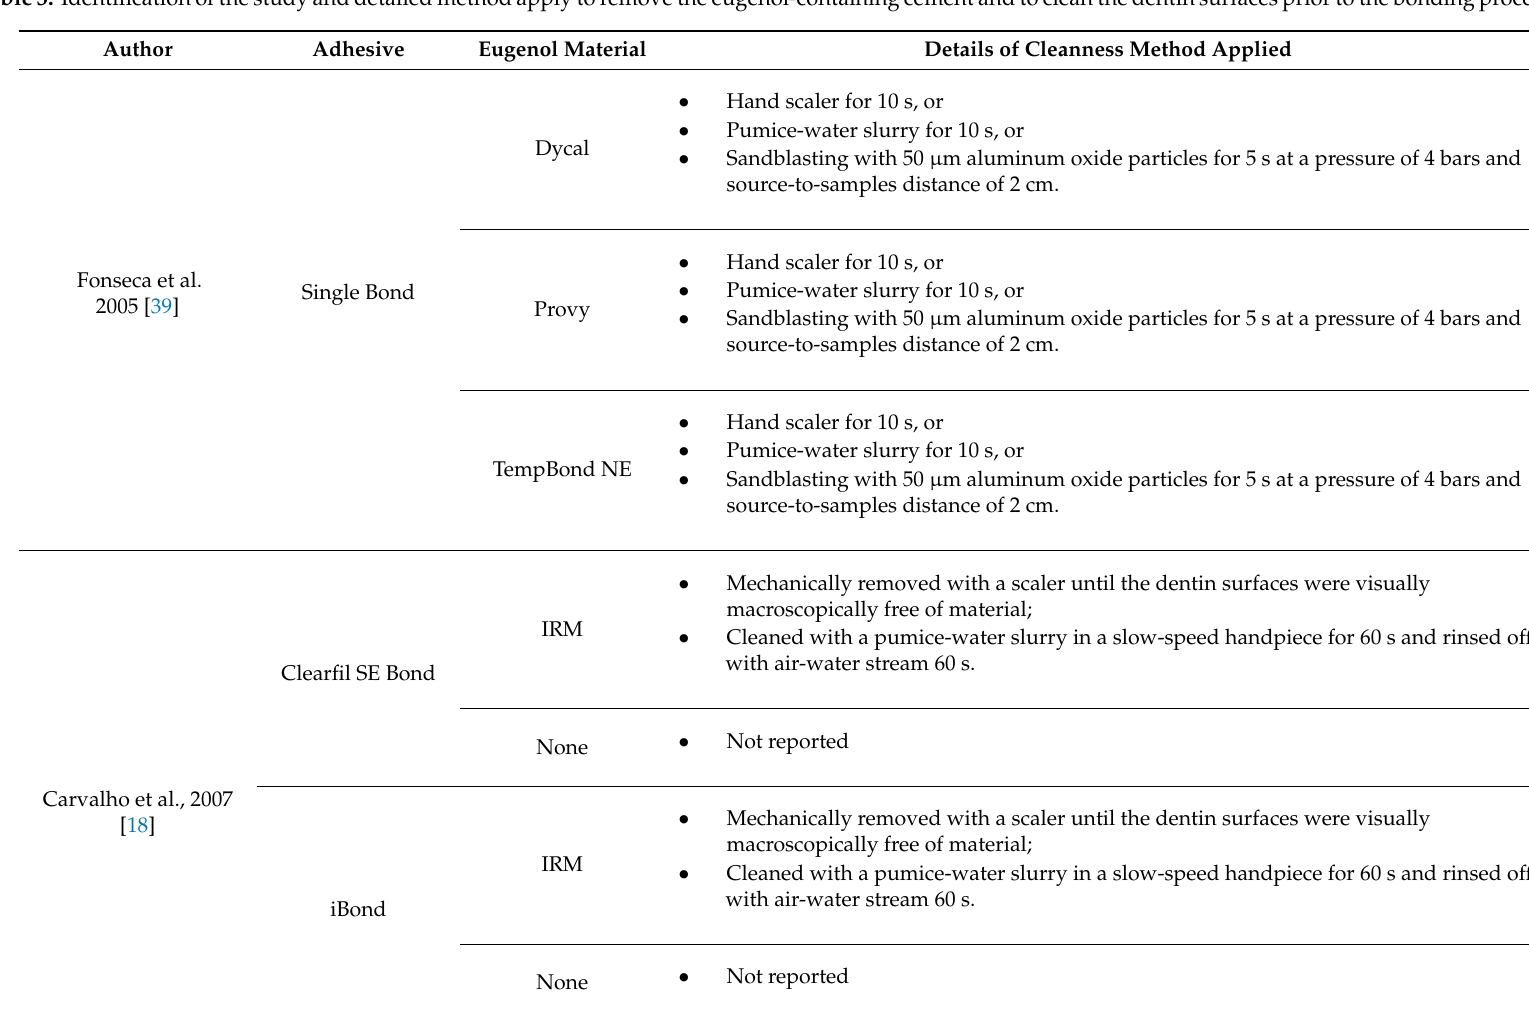
Table 3. Identification of the study and detailed method apply to remove the eugenol-containing cement and to clean the dentin surfaces prior to the bonding